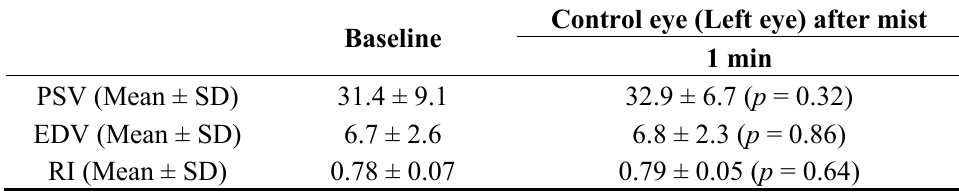
Table 2. Stage 1: Baseline comparison with the control eye after 1 min of mist.